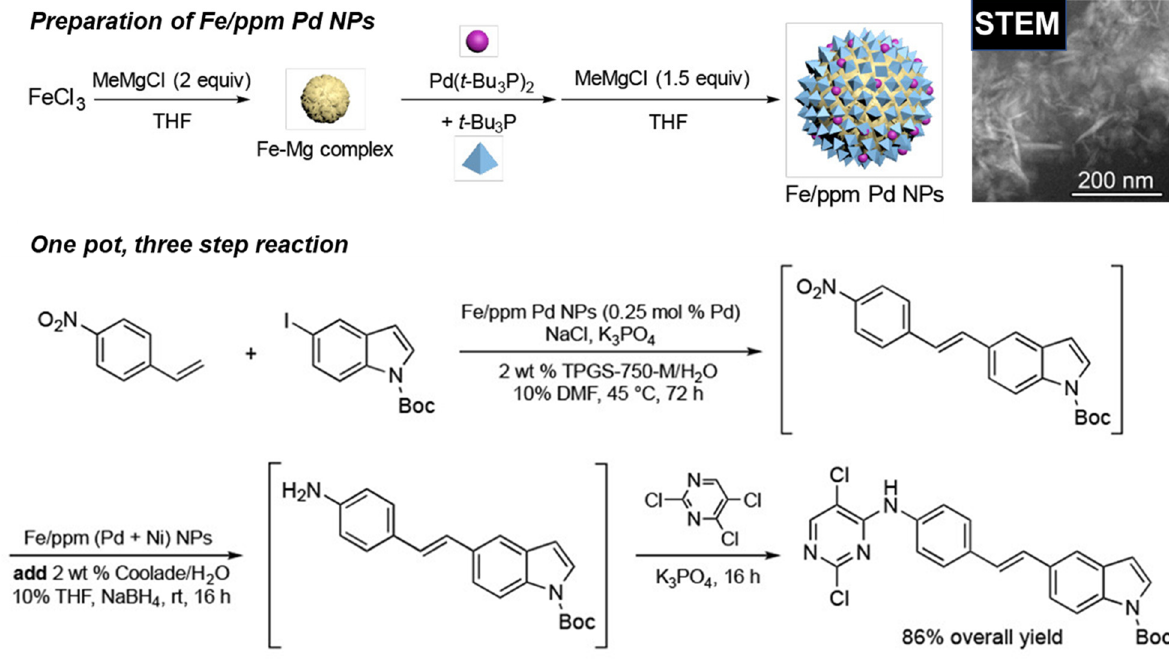
Figure 10. Preparation of iron-based particles containing ppm levels of palladium (Fe/ppm Pd). Initially formed NPs were spherical, measuring 2–5 nm. Upon addition of an aqueous solution of TPGS-750-M, the spheres were converted to nanorods (scanning TEM (STEM) image shown). A one-pot, three-step reaction sequence involving Mizoroki–Heck coupling was subsequently performed without isolation by nitro-group reduction using added Fe/ppm (Ni + Pd) NPs and ligandless nanoparticles in 2 wt% Coolade/H 2 O to avoid foaming from NaBH4. The resulting aniline was then treated directly with 2,4,5-trichloropyrimidine, leading to an S N Ar reaction. The final product was isolated by extraction and flash chromatography with 86% overall isolated yield. Adapted with permission from [128].